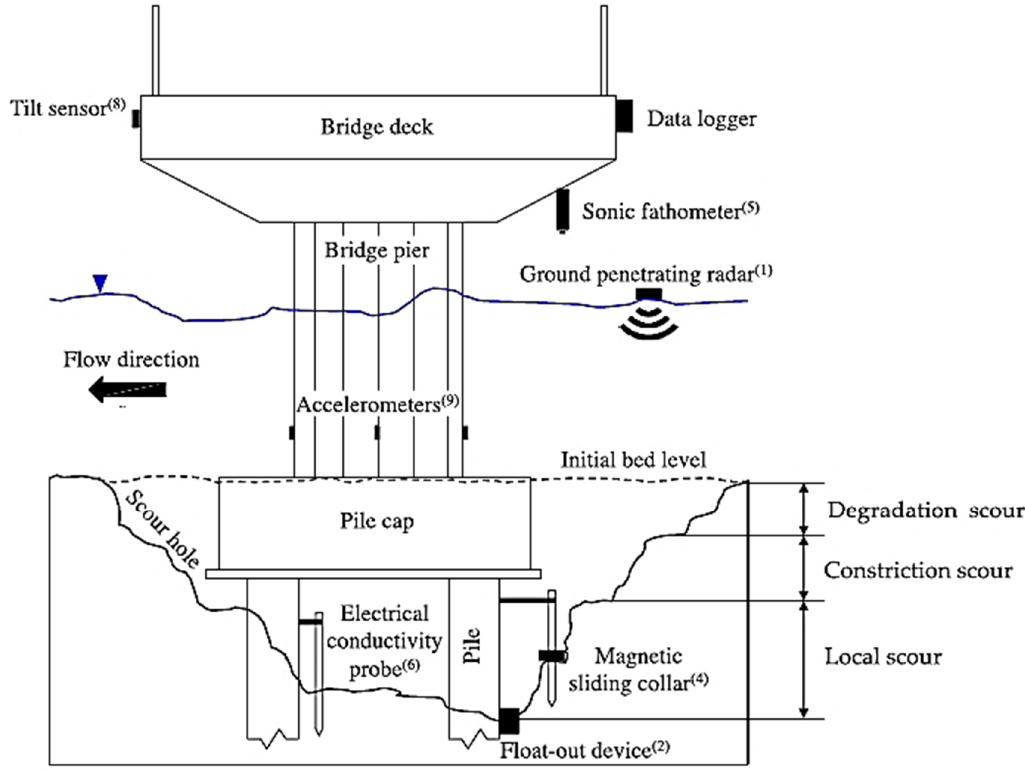
Figure 1. Scour monitoring devices - copied from